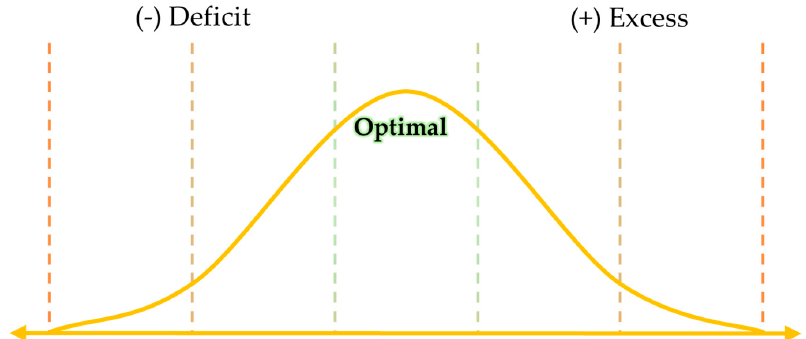
Figure 2. Graphic representation of the agroclimatic compatibility criteria. Table 2. Agroclimatic compatibility criteria of Moringa, Olive, Soybean, Rapeseed, Sunflower, and Jatropha.